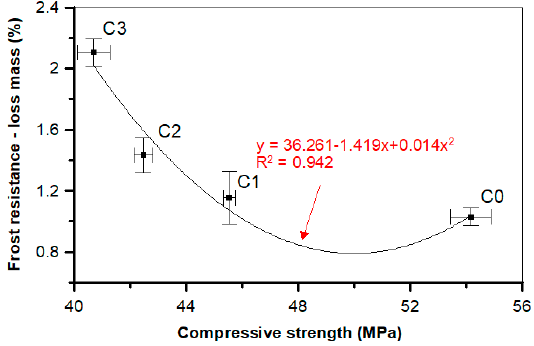
Figure 23. Relationship between compressive strength and frost resistance after 180 concrete freezing and thawing (F-T) cycles.